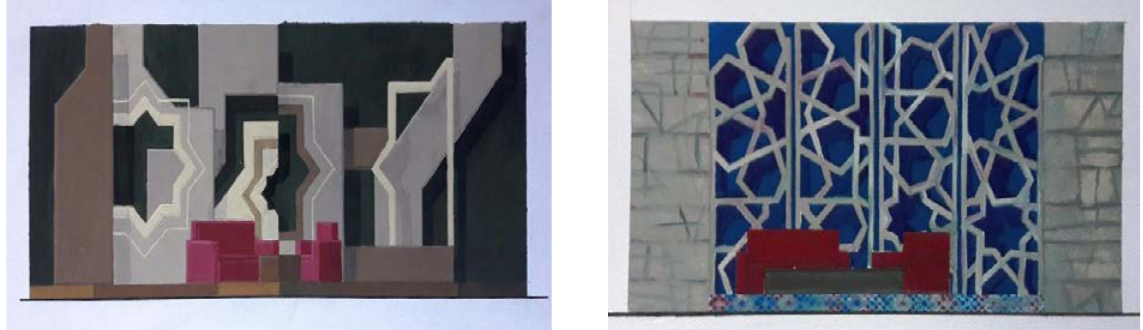
Figure (6): Live samples of student’s studio work with Prof. Ahmed Hosni on Folklore Projects. Source: Prof. Ahmed Hosni photos